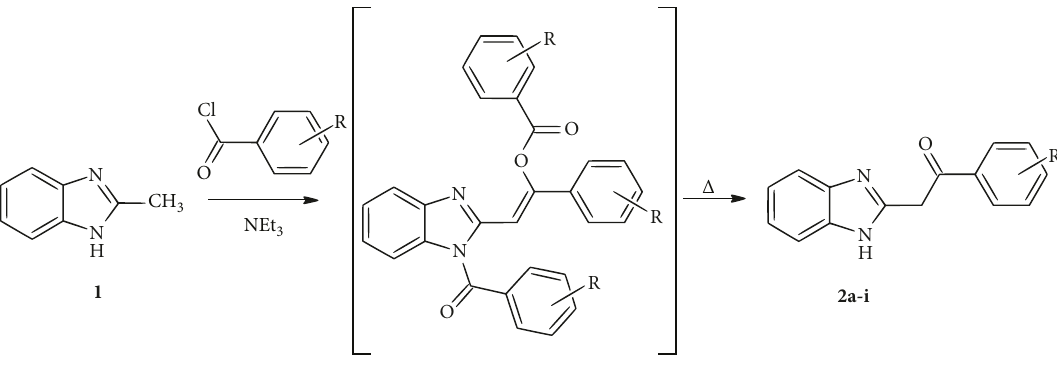
Scheme 2: Synthesis of